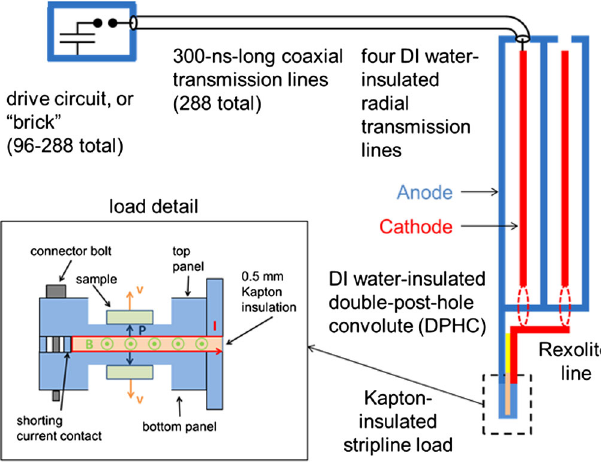
FIG. 1. Conceptual design of Thor. Also shown is the cross- sectional ICE load detail depicting the magnetic pressure exerted on the panels and samples.